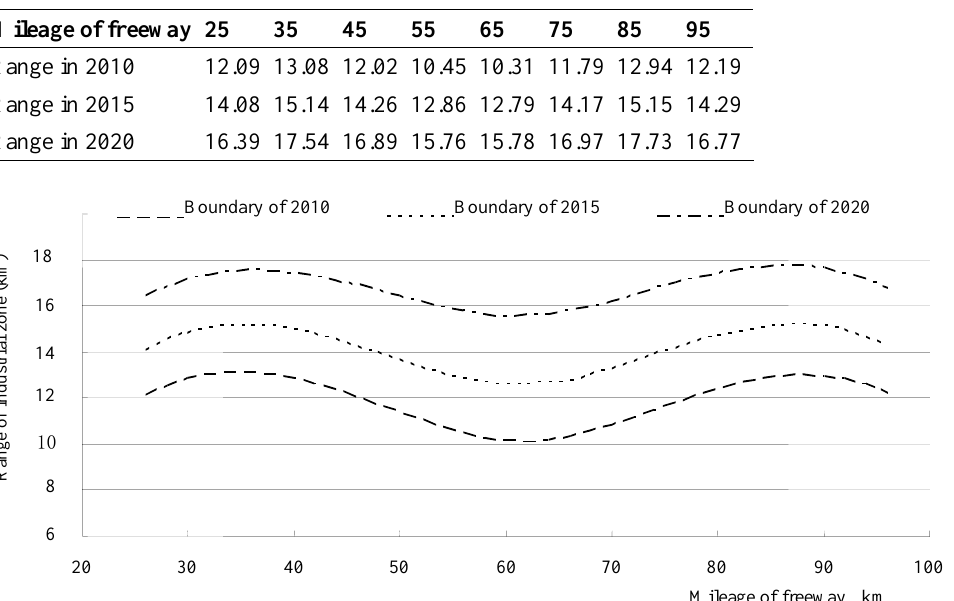
Table 5. The unilateral range of industrial zone in each characteristic spot along Ha- Shuang freeway (km)